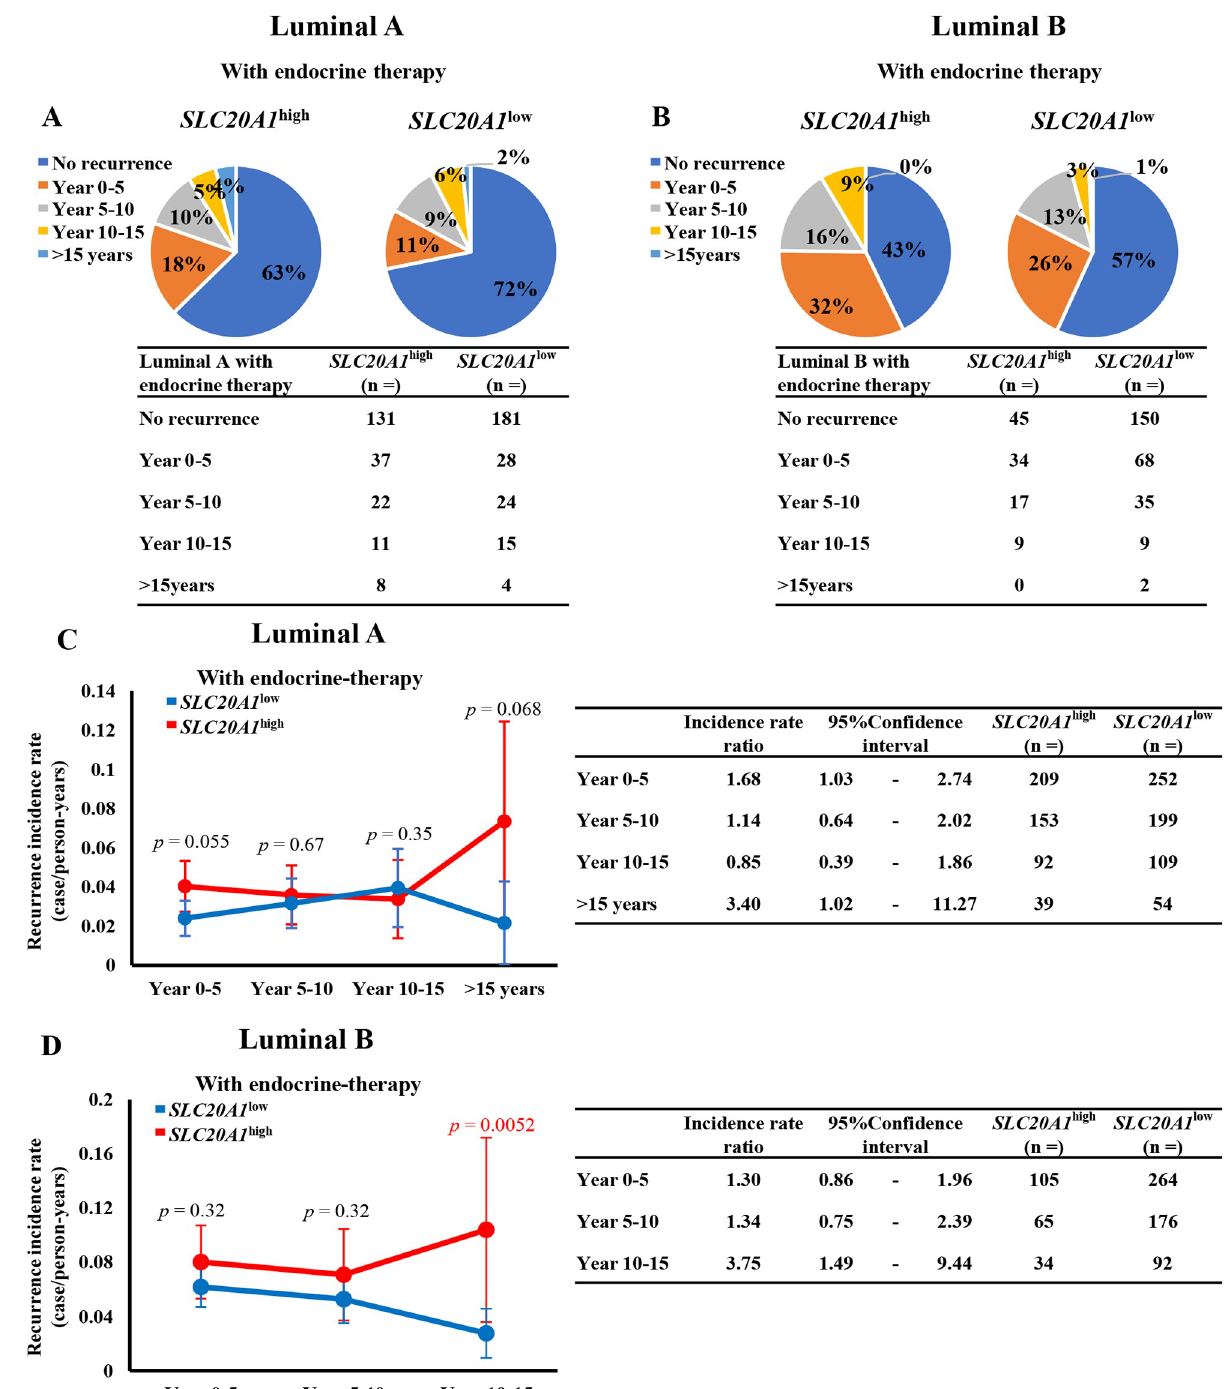
Fig 7. High solute carrier family 20 member 1 (SLC20A1) expression ( SLC20A1 high ) confers higher recurrence incidence rates compared with patients with low SLC20A1 expression ( SLC20A1 low ) after long periods of time in both luminal A and luminal B subtypes. (A-B) Pie charts of the recurrent period and number of patients in the SLC20A1 high and SLC20A1 low groups amongst those with luminal A or luminal B breast cancer. (A) Patients with SLC20A1 high (left) and SLC20A1 low (right) luminal A. (B) Patients with SLC20A1 high (left) and SLC20A1 low (right) luminal B. (C-D) Line graphs showing the recurrence incidence rates of patients in the SLC20A1 high and SLC20A1 low luminal A or luminal B groups every 5 years with or without endocrine therapy. P -values were calculated using the statistic based on normal distribution and corrected using the Holm method. The incidence rate ratio was calculated as the ratio of the recurrence incidence rate of SLC20A1 high to that of SLC20A1 low . The 95% confidence interval and the number of patients were shown on the right sides. (C) Patients with luminal A. (D) Patients with luminal B.